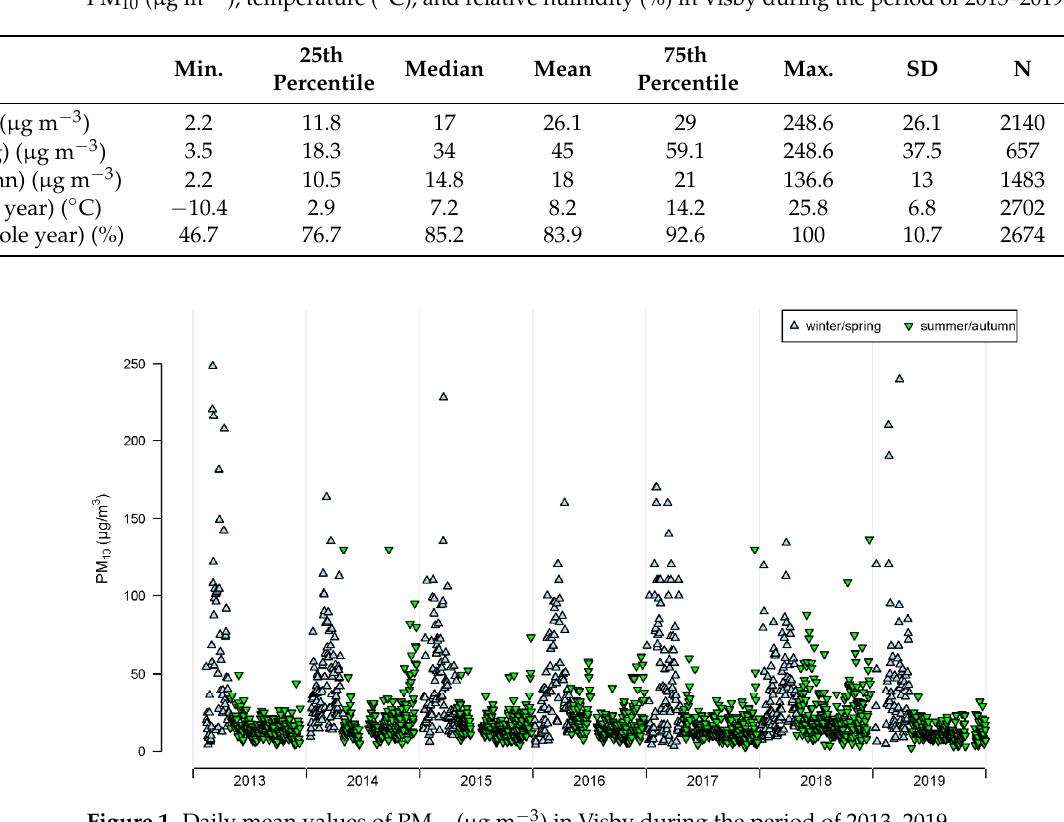
Figure 1. Daily mean values of PM 10 (µg m − 3 ) in Visby during the period of